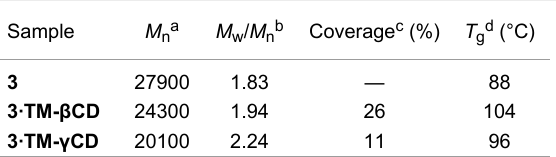
Table 1: Physicochemical characteristics of 3 , 3·TM- β CD and 3·TM- γ CD